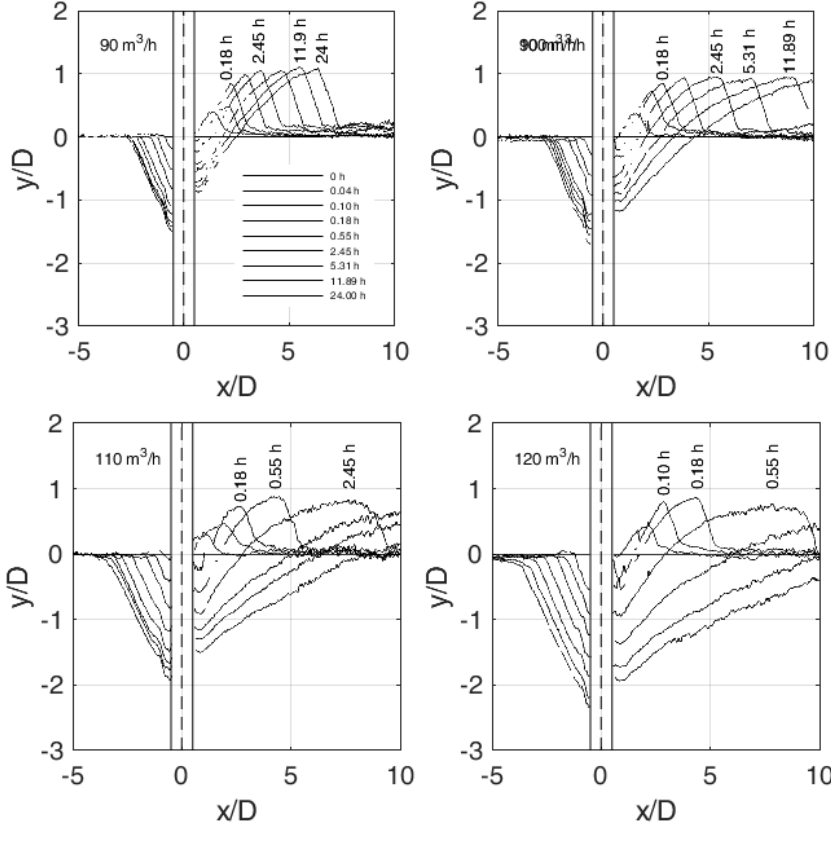
Figure 5. The profiles of the bottom for some time instants.